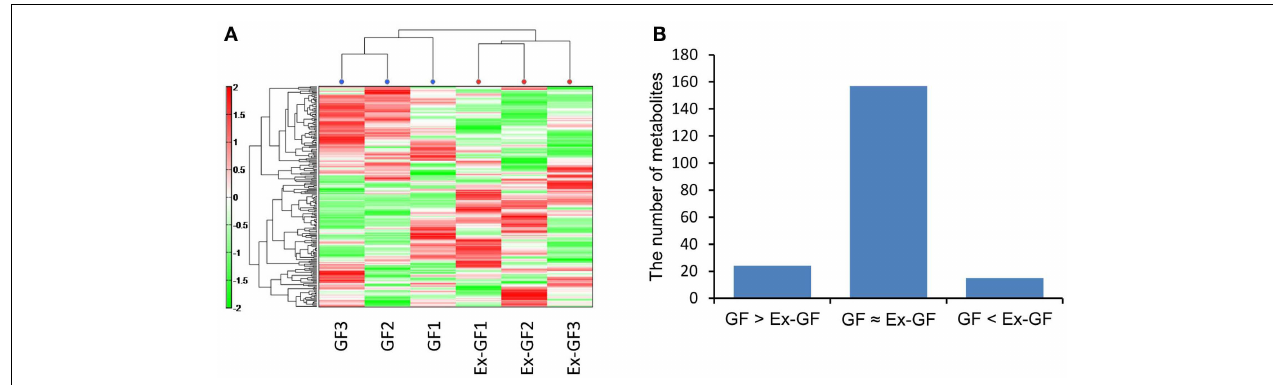
FIGURE 1 | Difference in the cerebral metabolome between GF mice and Ex-GF mice . (A) Hierarchical clustering showing patterns of metabolites. Red and green indicate high and low concentrations of metabolites, respectively. (B) The number of cerebral metabolites in the group. GF > Ex-GF; GF ≈ Ex-GF; and GF < Ex-GF.